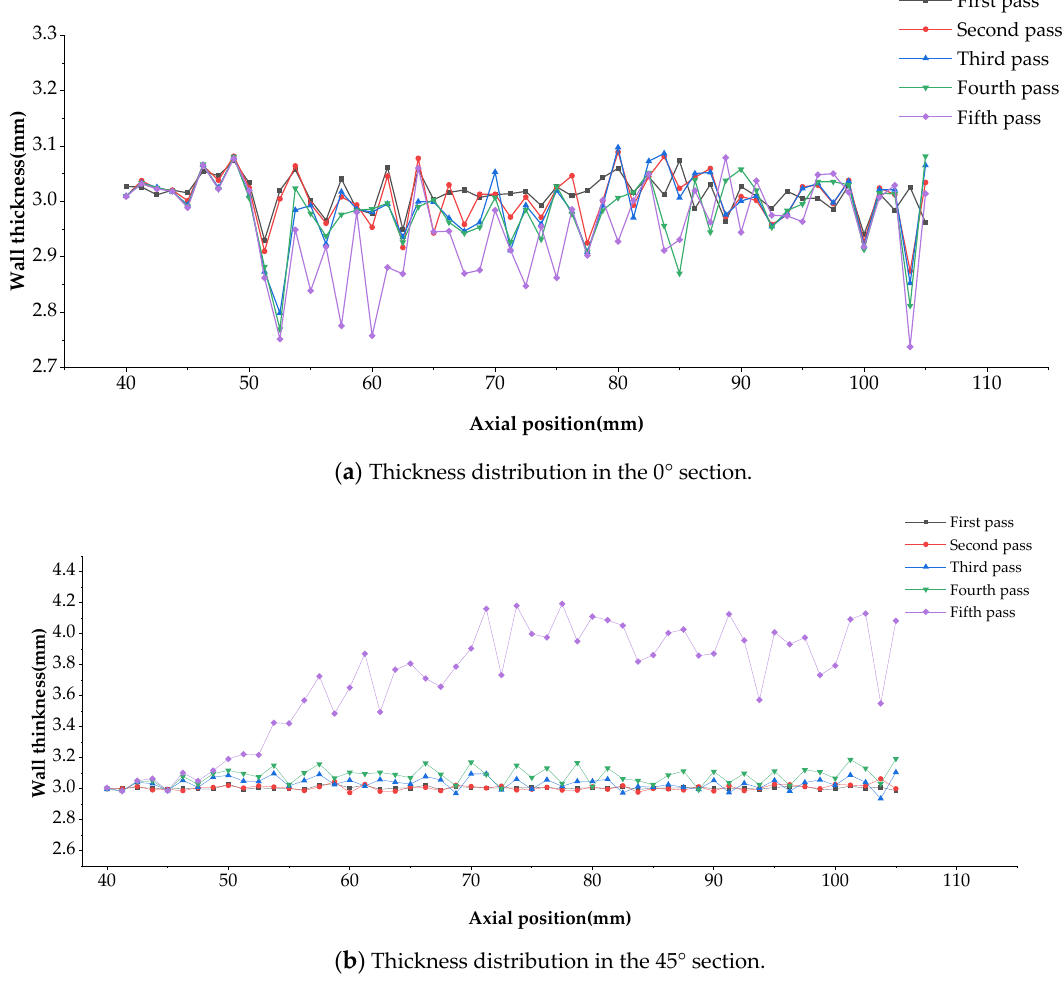
Figure 9. Thickness distribution in the 0° and 45° sections.